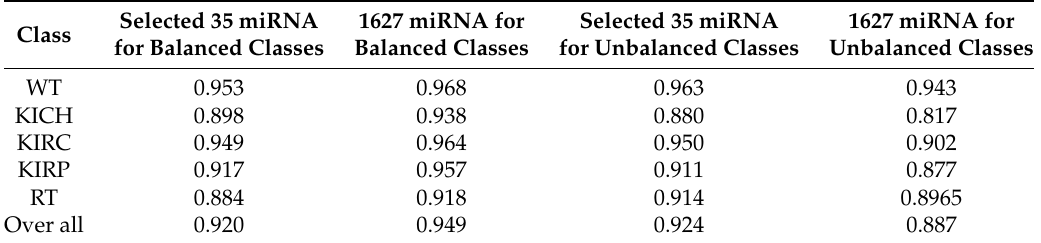
Table 5. Classification performance in terms of Matthews Correlation